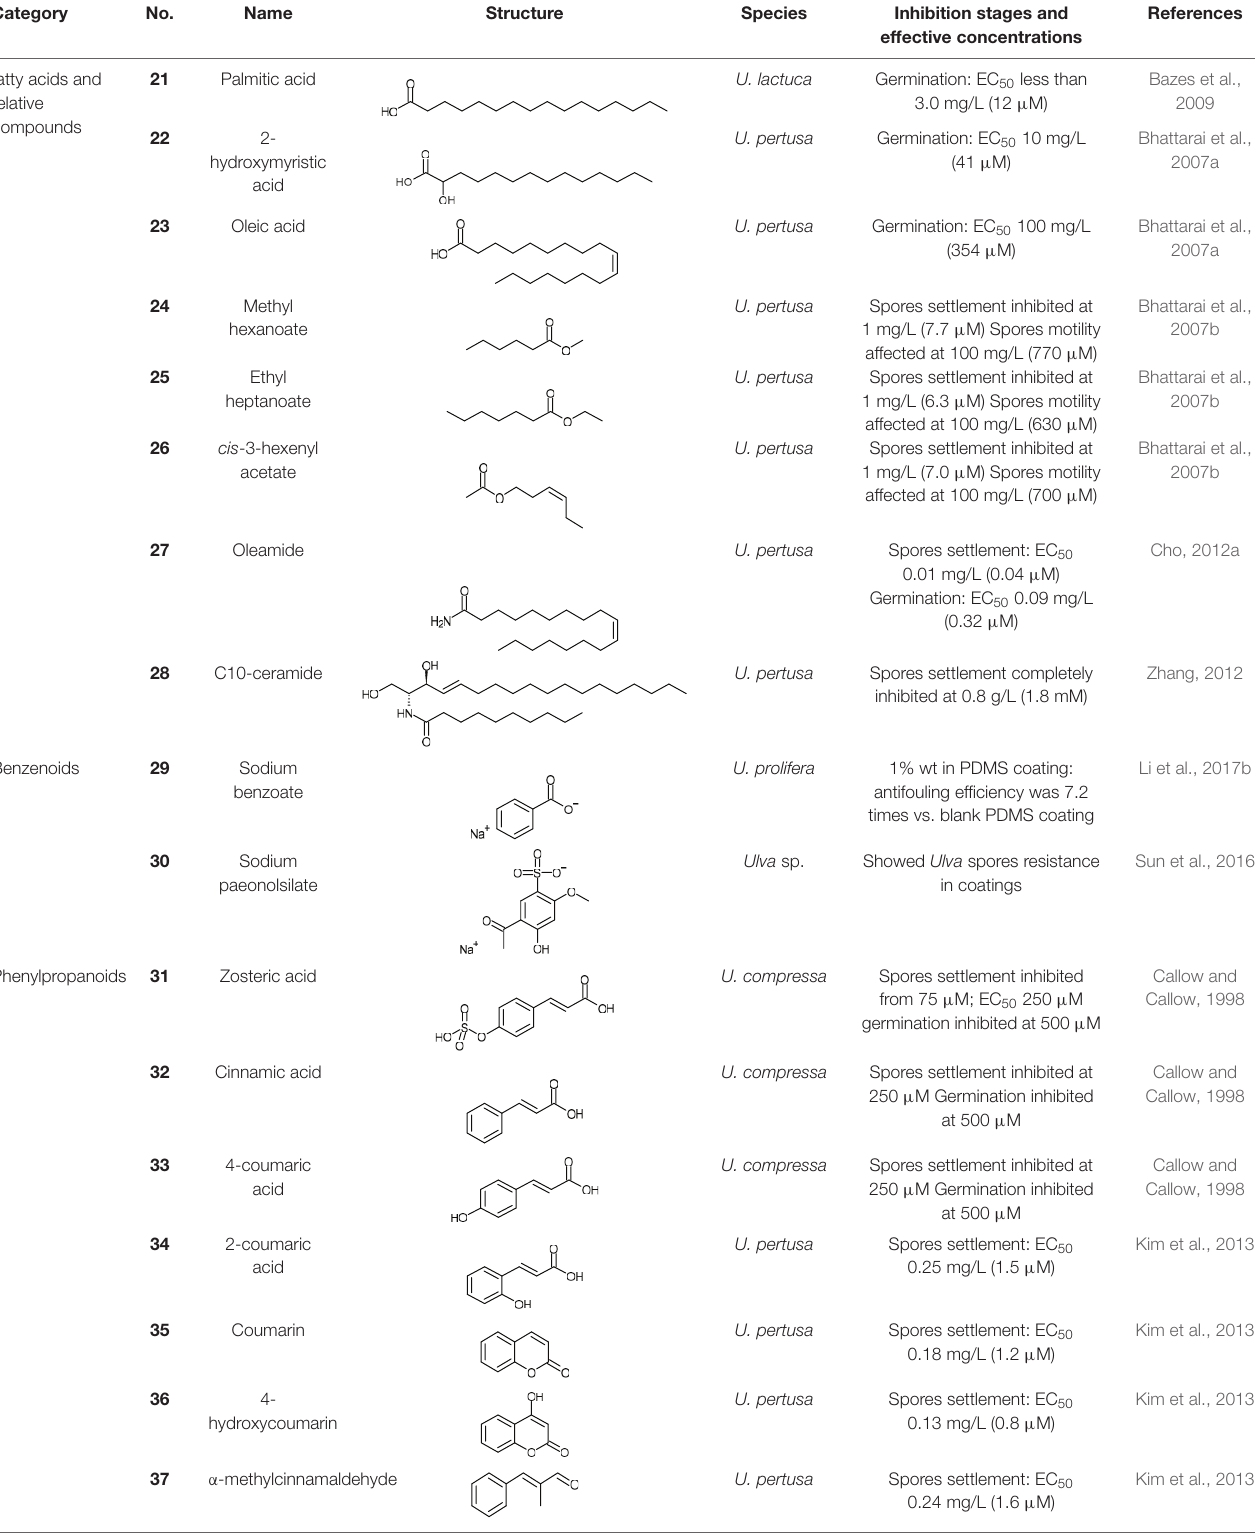
TABLE 4 | Natural allelochemicals and derivatives with Ulva -inhibiting activity. Category No. Name Structure Species Inhibition stages and